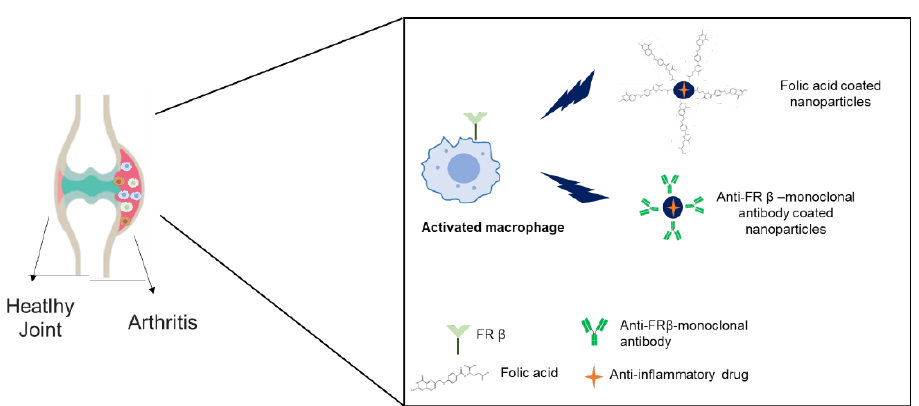
Figure 5. Summary of FR-targeted nanoformulations developed for inflammatory diseases.